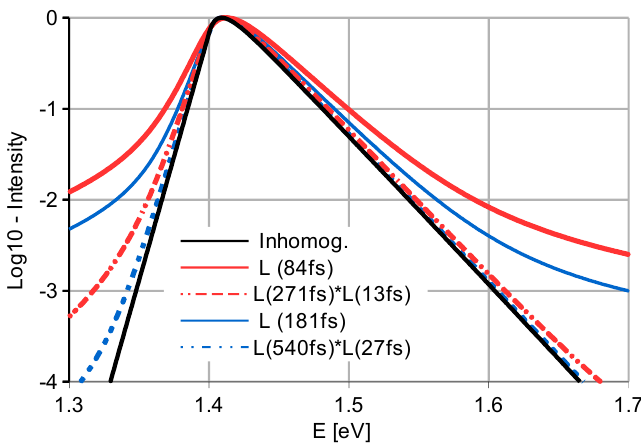
Figure 4. Simulation for homogeneous broadening in bulk semiconductor using two homogeneous lineshapes, Equations (2) and (10). Inhomogeneous line with parameters: Bulk ρ Jdos ∝ (cid:112) E − E g , E g = 1.4 eV, E b = 8 meV, E u = 8 meV and T = 293